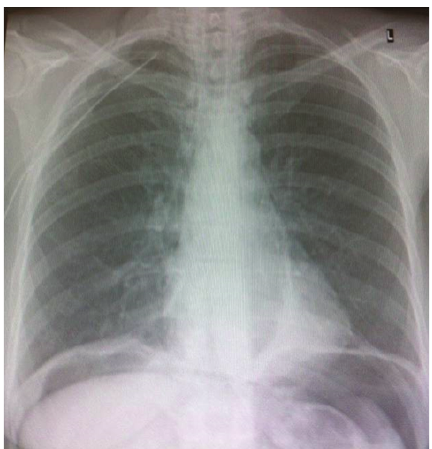
Figure 2: Chest X-ray after the insertion of a right-sided chest tube. Pneumothoraxhascompletelyresolved.ExistenceofIntraperitoneal free air.